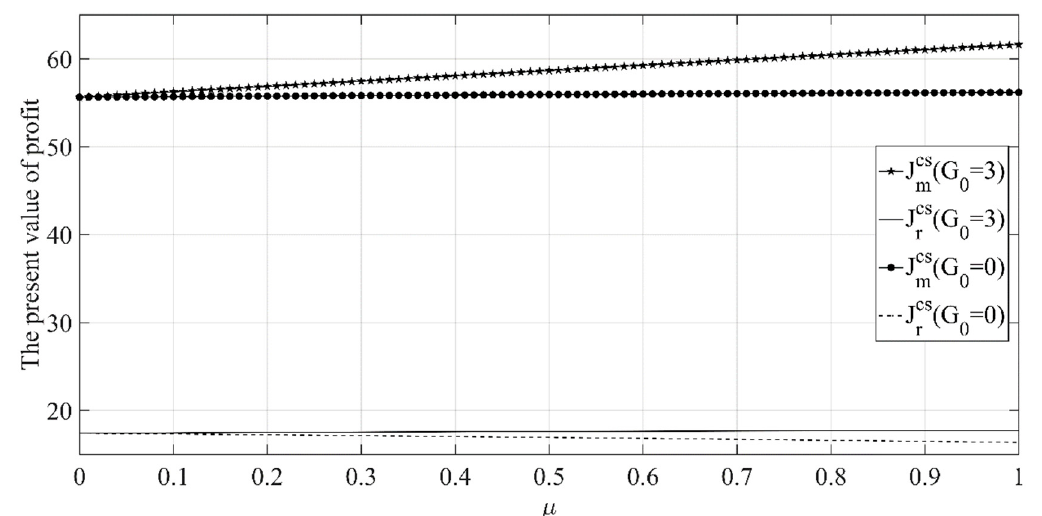
μ on profits. Figure 9. The impact of µ on